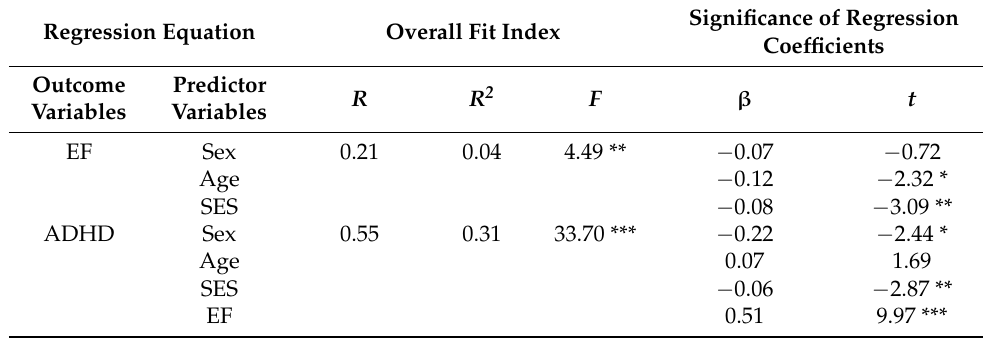
Table 3. The regression analysis of SES and overall EF on ADHD in preschool